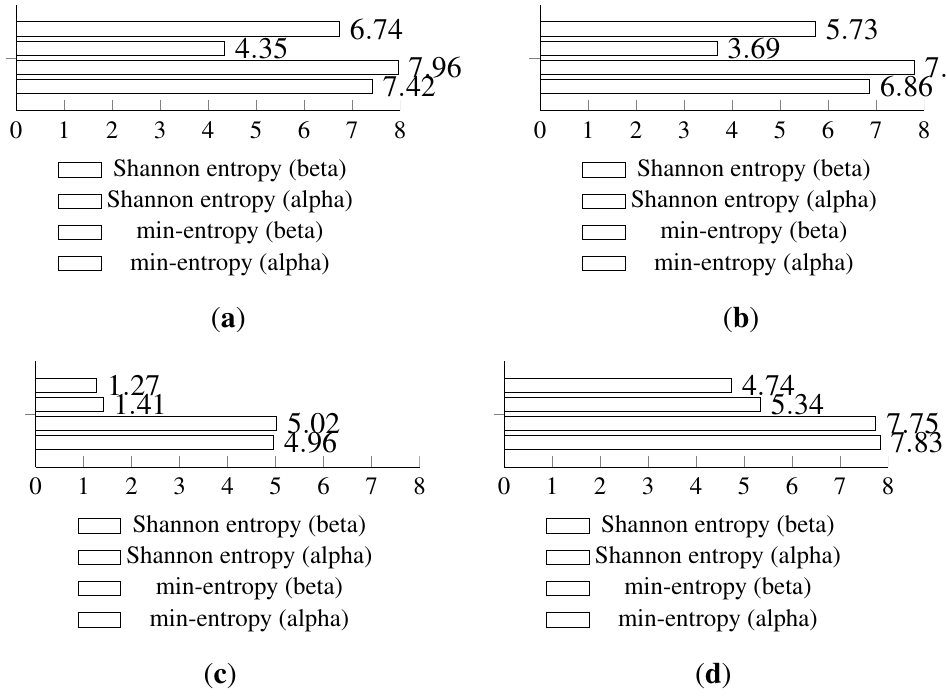
Figure 12. Shannon entropy and min-entropy estimations of the results gathered from the alpha and beta devices during the isolation experiment. ( a ) Light (1); ( b ) Light (2); ( c ) humidity; ( d )